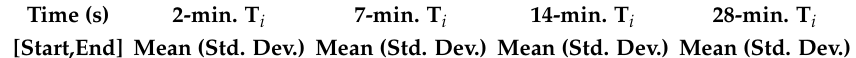
Table A1. Trial #7: L 2 Position Errors (cm) for Configuration C ψ , z using Est. Speed and Est. Heading.